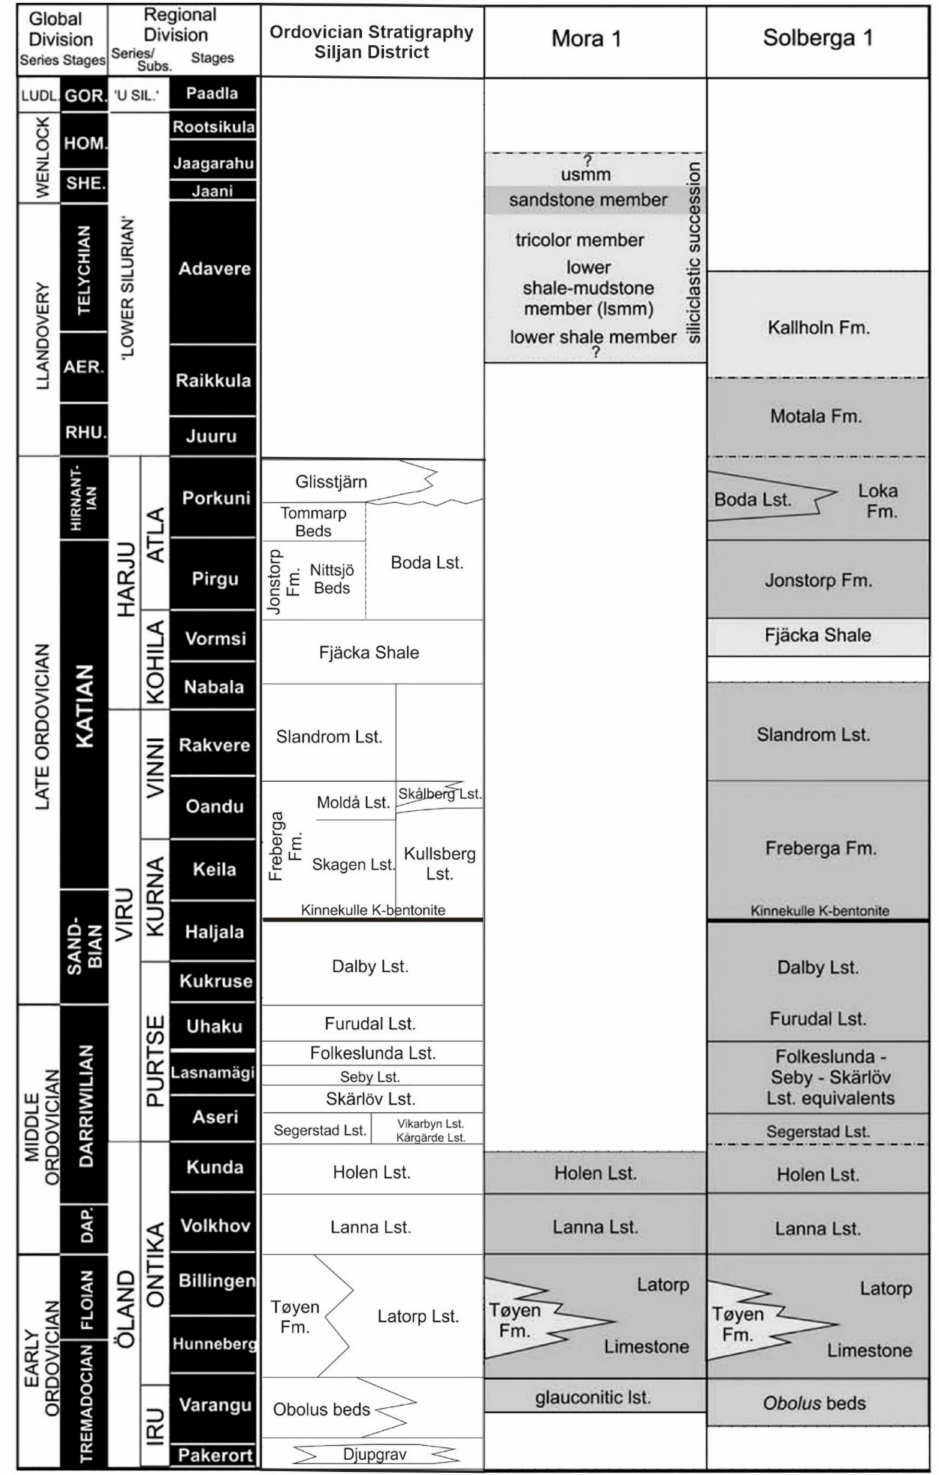
Figure 2. Combined stratigraphic diagram of the Ordovician sedimentary succession in the Siljan District (modified from Ebbestad and Högström 2007 [1]) and lithostratigraphic columns of the Mora 1 and Solberga 1 core sections (according to data from Lehnert et al., 2012